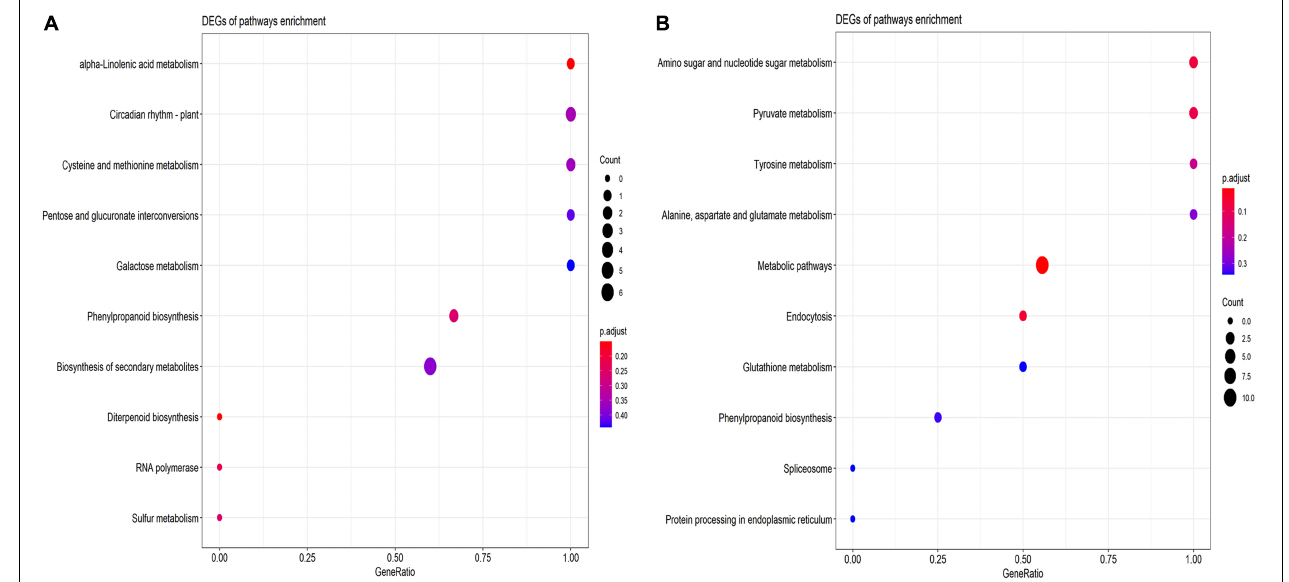
FIGURE 7 | Advanced bubble chart shows putative KEGG pathways in (A) drought (B) salt stress conditions. The x-axis represents GeneRatio, which is the ratio of the number of DEGs and all annotated genes. The y-axis denotes the enriched pathways. Enrichment significance is shown with color and bubble size denotes the number of DEGs enriched in the pathway.